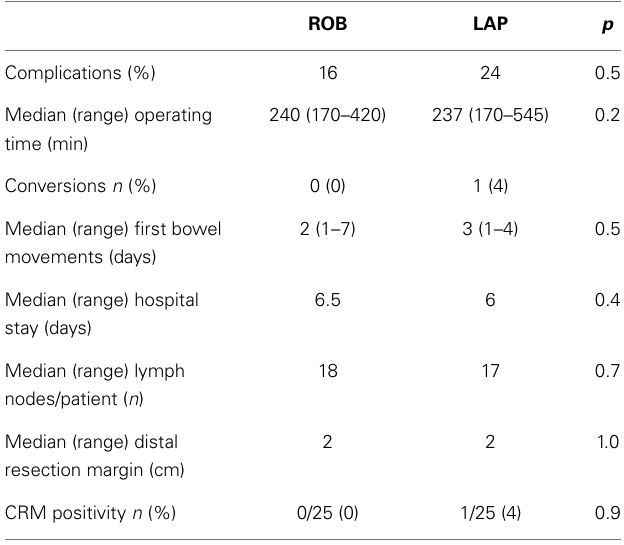
Table 4 | Clinical and oncologic outcomes of 50 minimally invasive total mesorectal excision (TME)